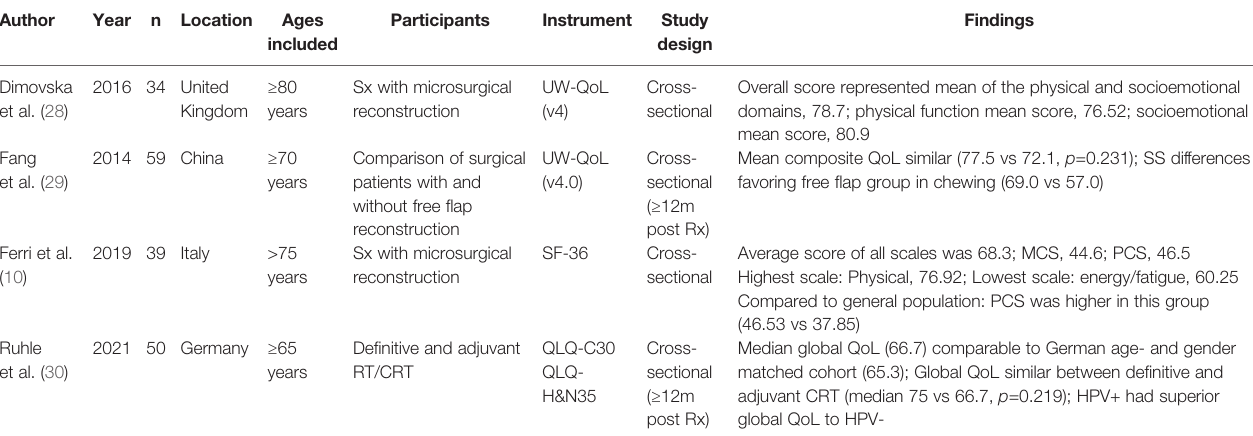
TABLE 4 | Studies reporting health-related quality of life outcomes enrolling only elderly patients with